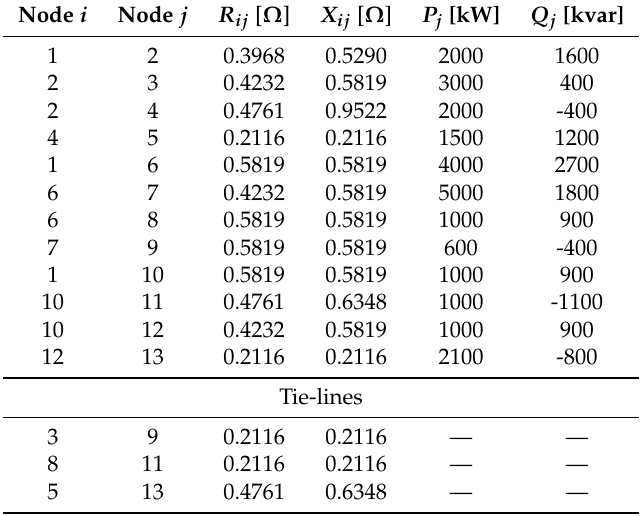
Table 2. Branch and load parameters of the 13-node test feeder. Node i Node j R ij [ Ω